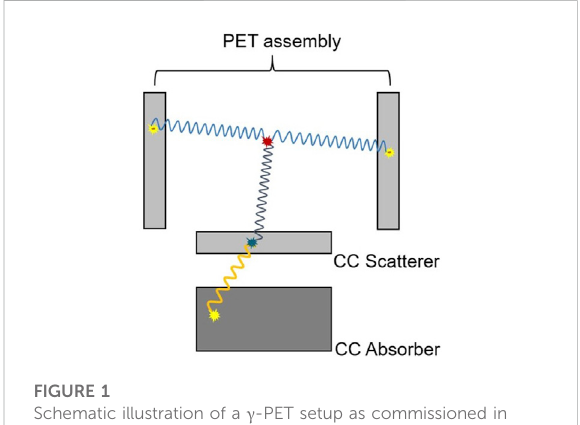
FIGURE 1 Schematic illustration of a γ -PET setup as commissioned in this